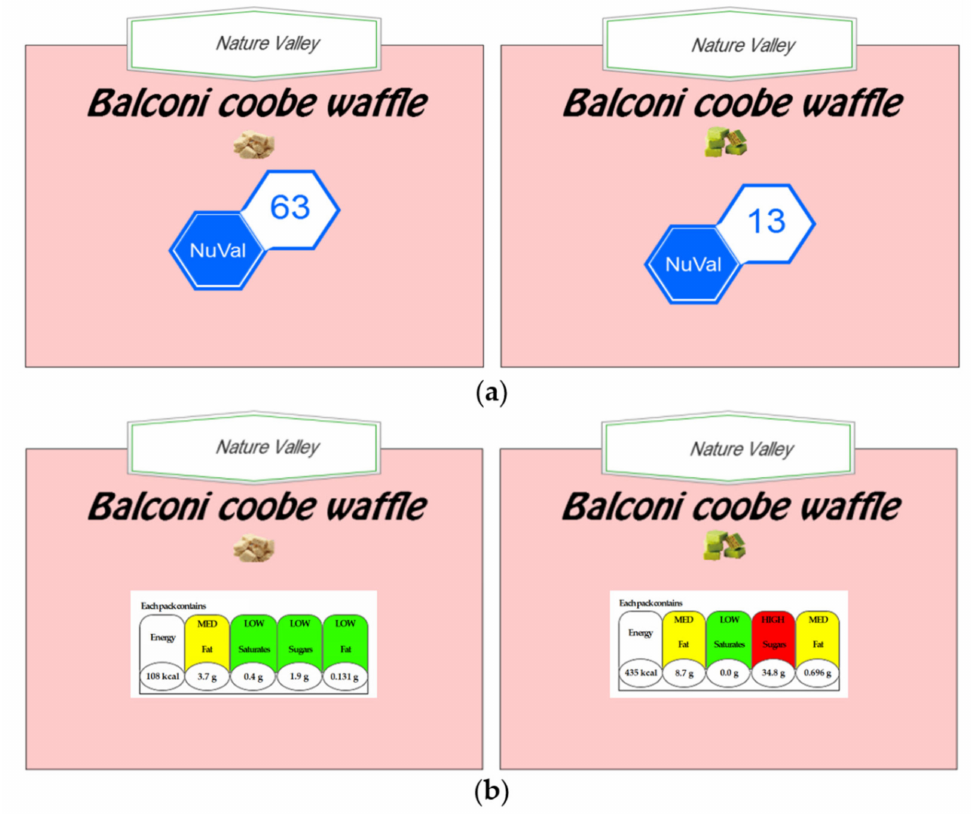
Figure 2. Examples of food images presented in Experiment 1: ( a ) illustrates a pair of waffles accom- panied by their respective NuVal labels; ( b ) illustrates the paired foods with the traffic light